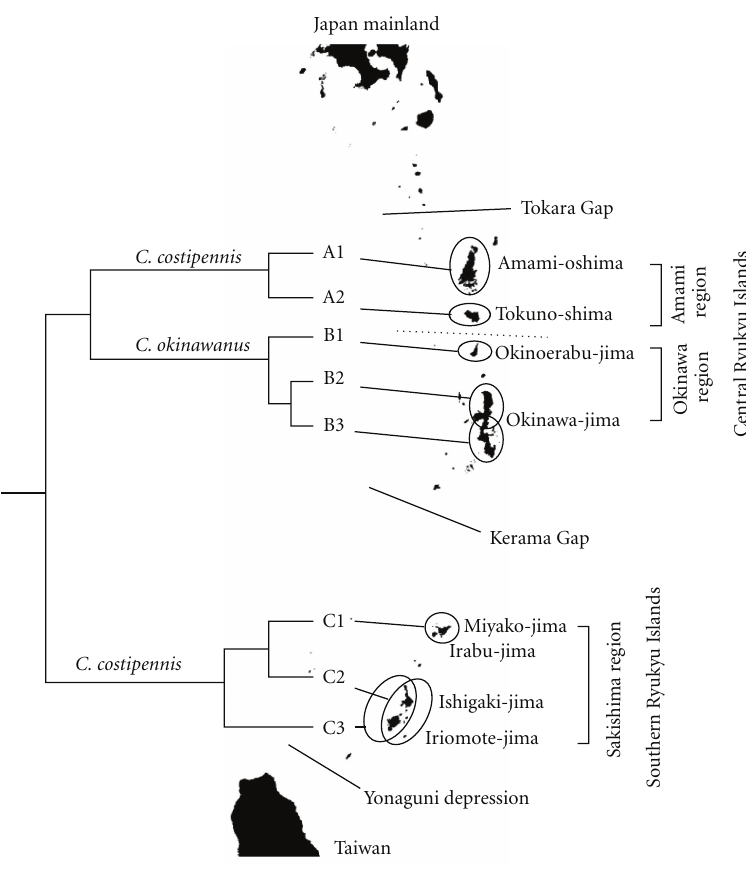
Figure 4: Phylogeography of Curtos fireflies in the Central and Southern Ryukyu